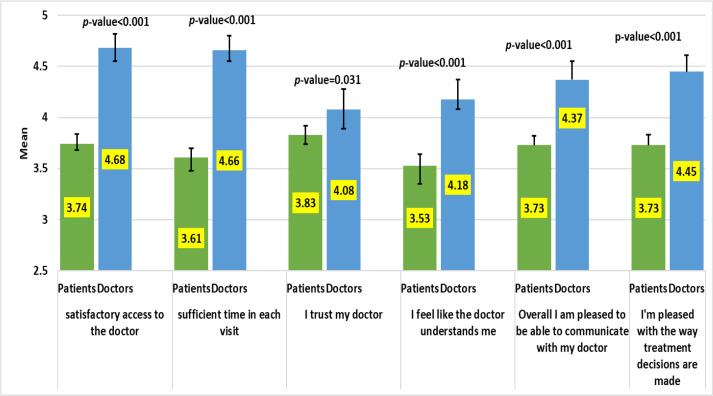
Factors influencing the quality of communication between patients and doctors.Note: p-values from t-tests of the mean difference between doctors and patients’ responses for each dimension.